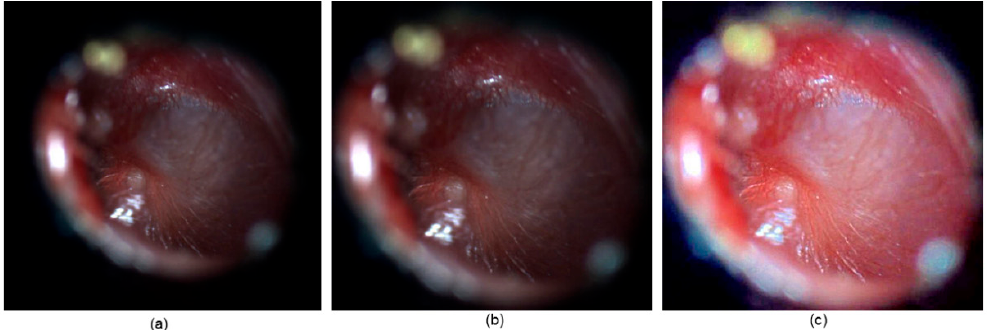
Figure 6. Example result of post-processing steps ( a ) original image generated by the composite image generator; ( b ) image cropped by applying converting to gray level, blurring with a Gaussian filter, gray level thresholding and identification of the coordinates of the area that is needed for subsequent processing; ( c ) image enhanced by a de-hazing technique.